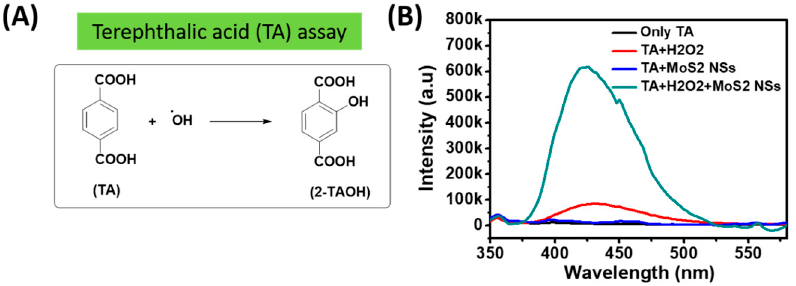
Figure 7. ( A ) reaction scheme of Terephthalic acid assay. ( B ) Photoluminescence spectra of Terephthalic acid assay at various conditions.